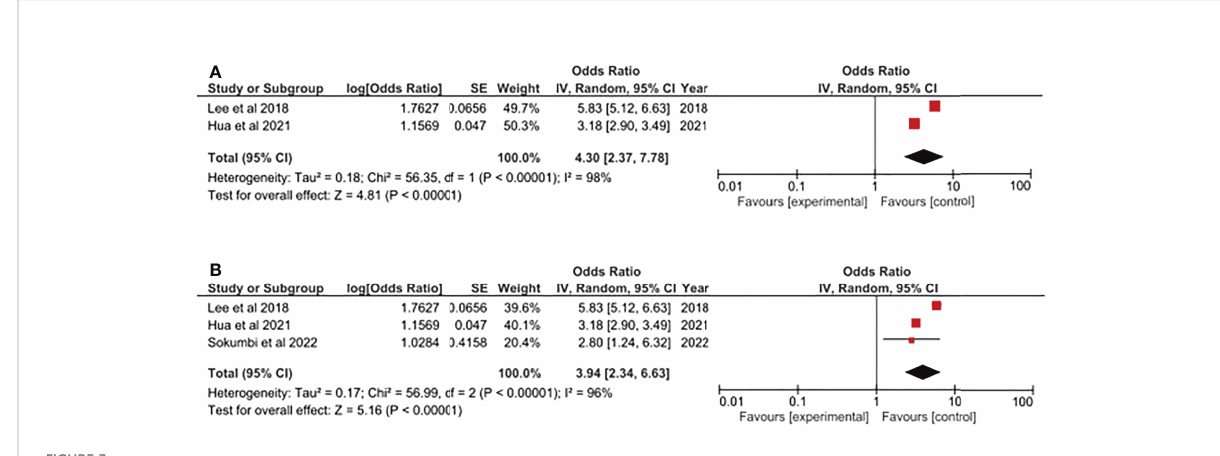
FIGURE 3 (A) Odds ratio of psoriasis in male population with Hidradenitis Suppurativa. (B) Odds ratio of psoriasis in female population with Hidradenitis Suppurativa.